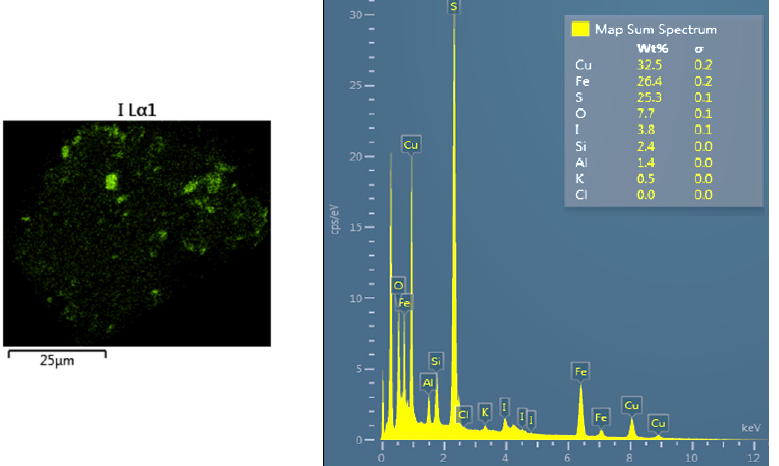
Figure 12. SEM and EDS micrograph of a CuFeS 2 particle with element distribution (Cu: orange, I: green). Test conditions: KI = 100 ppm, H 2 SO 4 = 0.5 M, T= 45 °C in seawater.